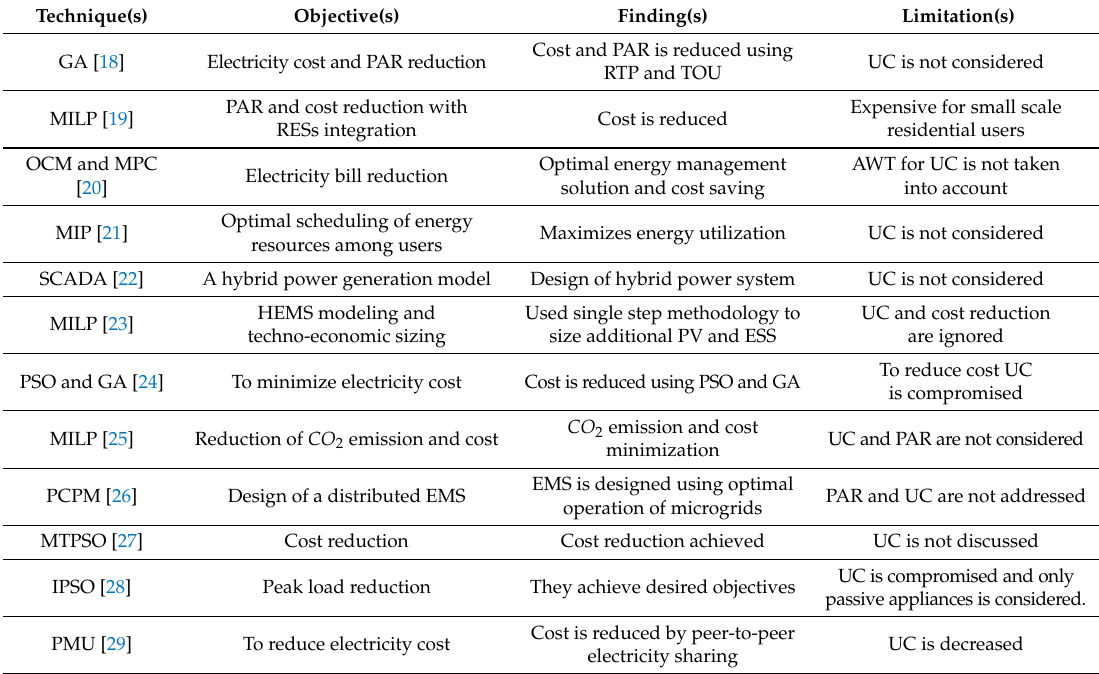
Table 1. Summarized literature